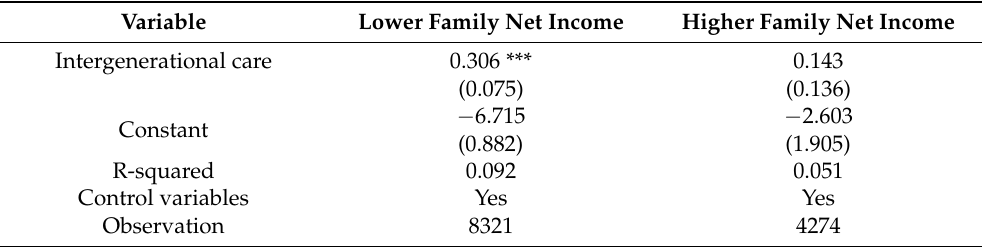
Table 5. The impact of intergenerational care on food diversity by income heterogeneity indicators among rural families (lower income family and higher income family) estimated